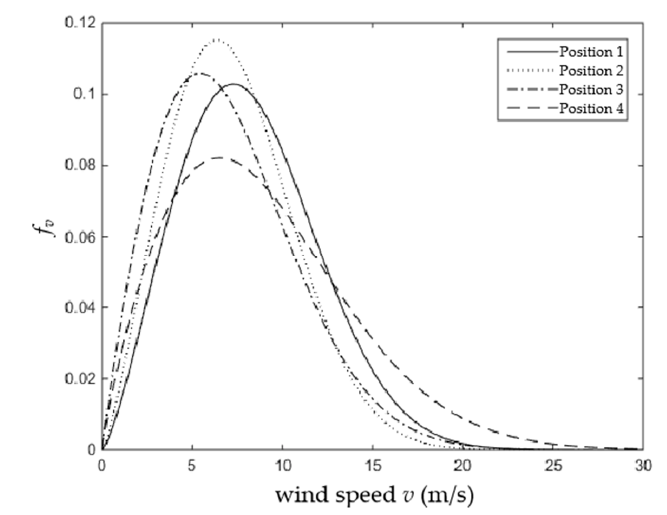
Figure 6. The probability density functions (PDFs) of wind speeds at Positions 1–4.